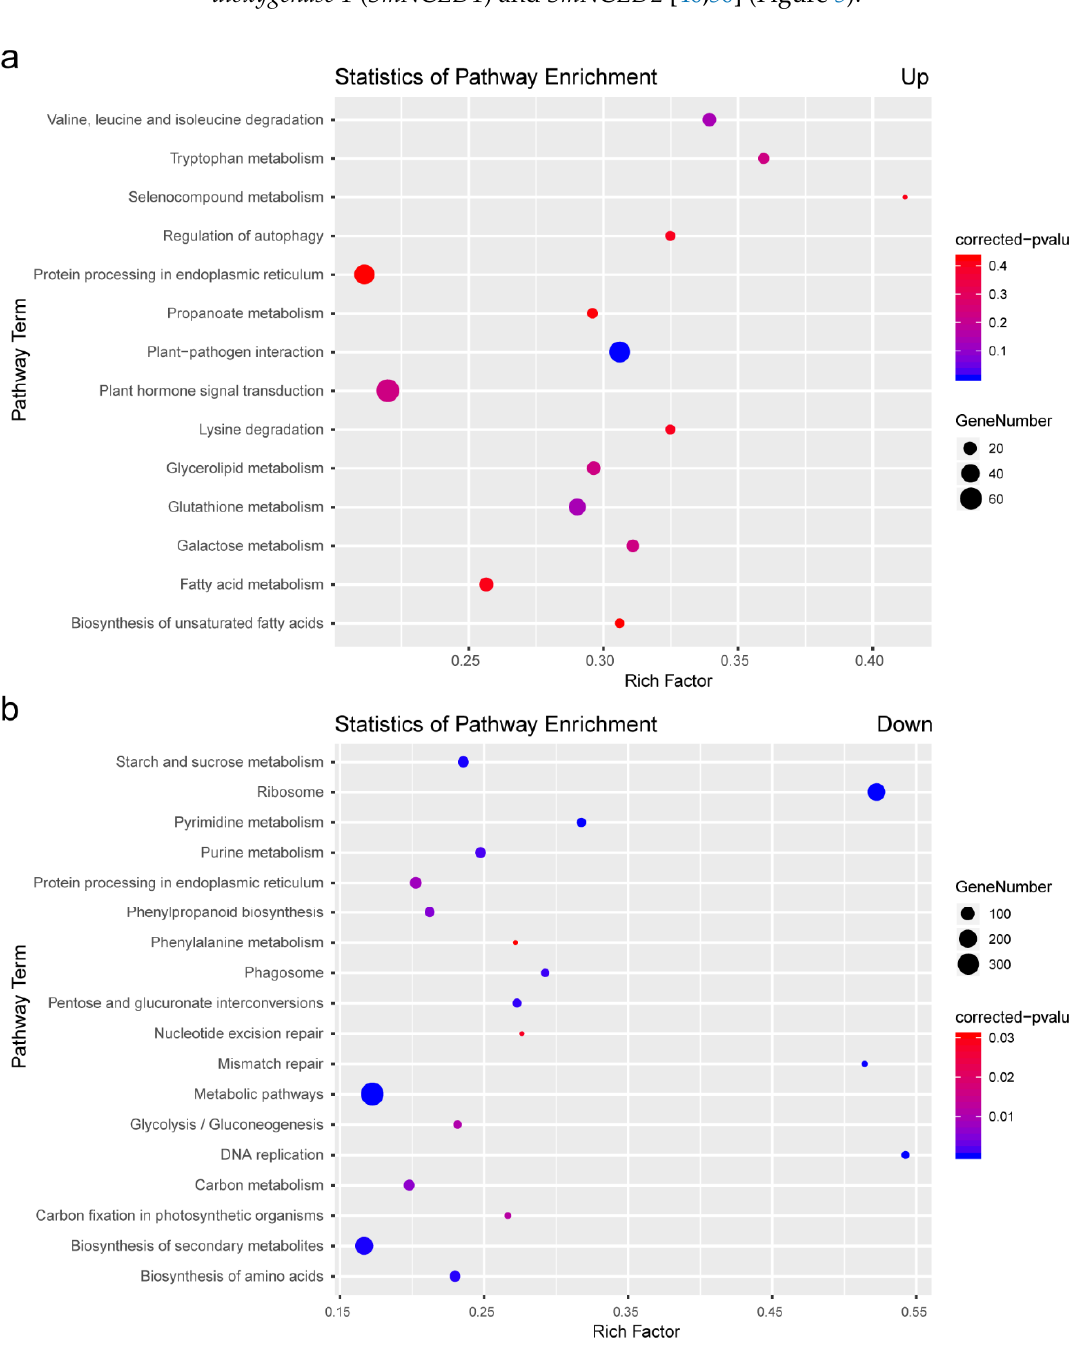
Figure 3. KEGG analysis of DEGs in eggplant roots under salt stress. KEGG analysis of the signifi- cantly up ‐ regulated ( a ) and down ‐ regulated ( b ) DEGs of the enriched pathways.